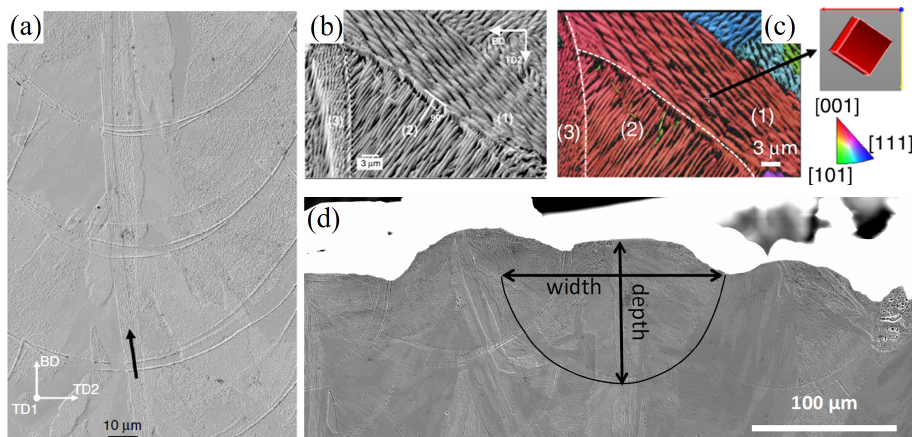
Figure 5. Microstructure development in AM 316L stainless steel A using bi-directional scan without rotation: ( a ) The continuous growth of grains in a slender domain (highlighted by a black row) along the centreline across melt pools, ( b ) cells in the region labeled (3) epitaxially grew from ones in the region (2) which did grow from existing cells in the region (1), ( c ) the corresponding inverse pole figure of grains in ( b ) indicating that the cells in regions labeled (1), (2), and (3) belong to the same grain due to epitaxial growth, but have 90° changes in the growth direction, ( d ) melt pools on the top layer of a 316L build with measured dimensions are 90 ± 20 µ m in depth and 145 ± 30 µ m in width. The dashed lines in ( b , c ) denote the melt pool boundary. (This figure is reproduced from [6]).